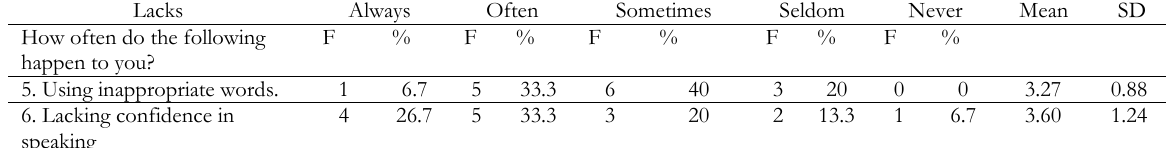
TABLE 5. S tudents’ perception of their speaking difficulties